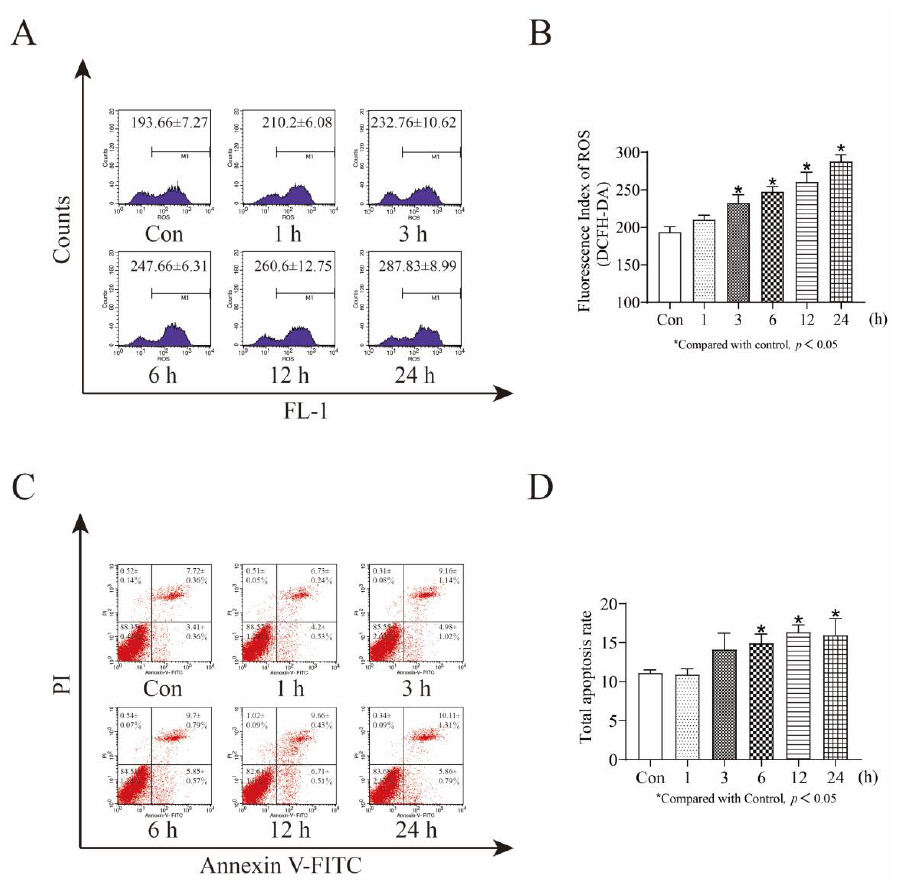
Figure 2. MeHg induces ROS accumulation and apoptosis in SH-SY5Y cells. ( A ) Flow cytometry detection of ROS levels in 1 µ M MeHg-treated SH-SY5Y cells for 1–24 h. ( B ) GraphPad Prism 8.0.2 software analyses of ROS levels. ( C ) Flow cytometry detection of apoptosis in 1 µ M MeHg-treated SH-SY5Y cells from 0–24 h. ( D ) Total apoptosis rate. Statistical significance was determined using ANOVA, p < 0.05. Abbreviations: DCFH-DA, ROS green fluorescent probe; ROS, reactive oxygen